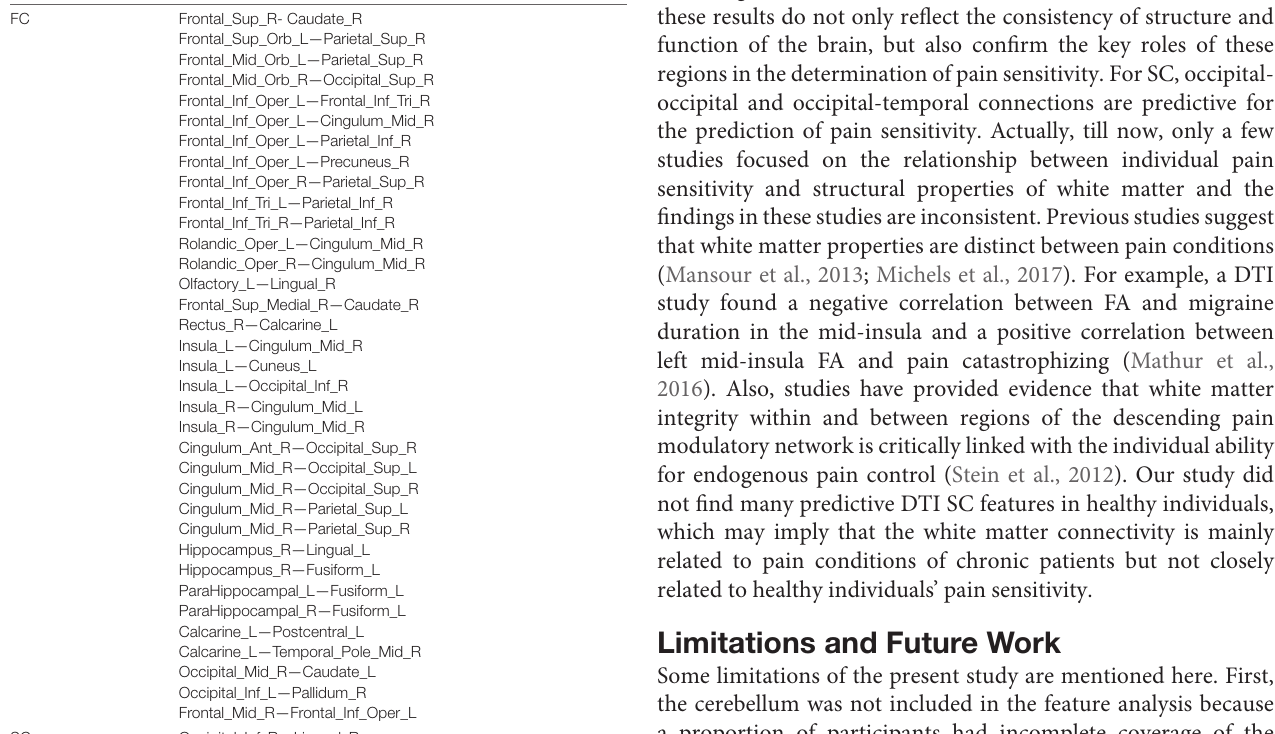
TABLE 3 | List of common predictive connectivity features for the prediction of laser pain threshold. Feature set Regions or